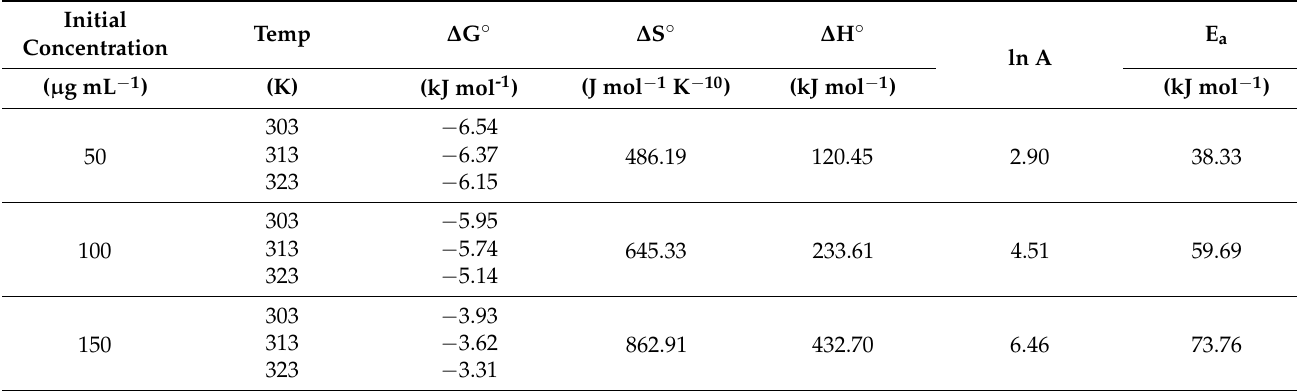
Table 6. Thermodynamic boundaries of BG-HNT framework.